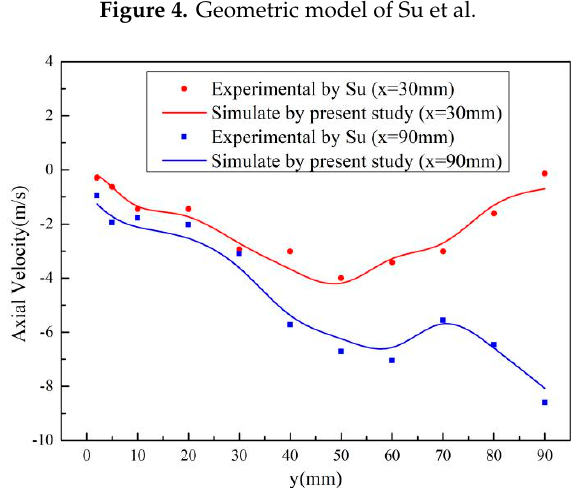
Figure 4. Geometric model of Su et al.